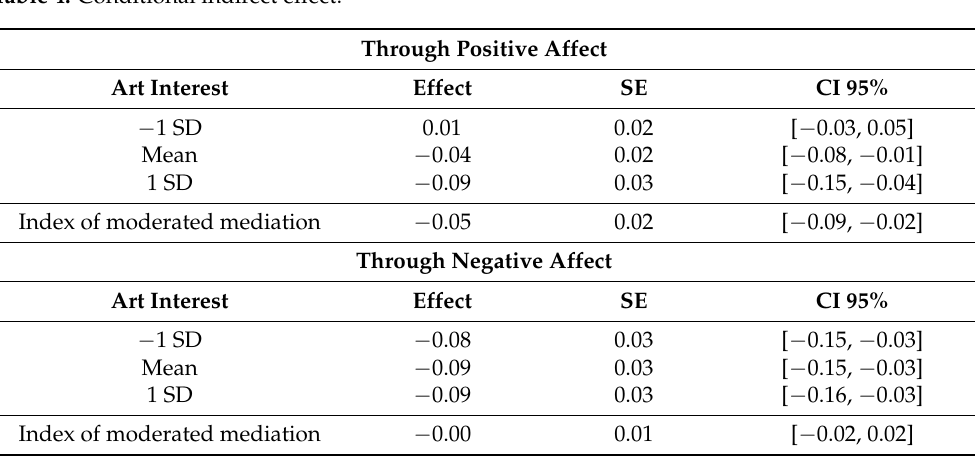
Table 3. Conditional effect of the focal predictor. Table 4. Conditional indirect